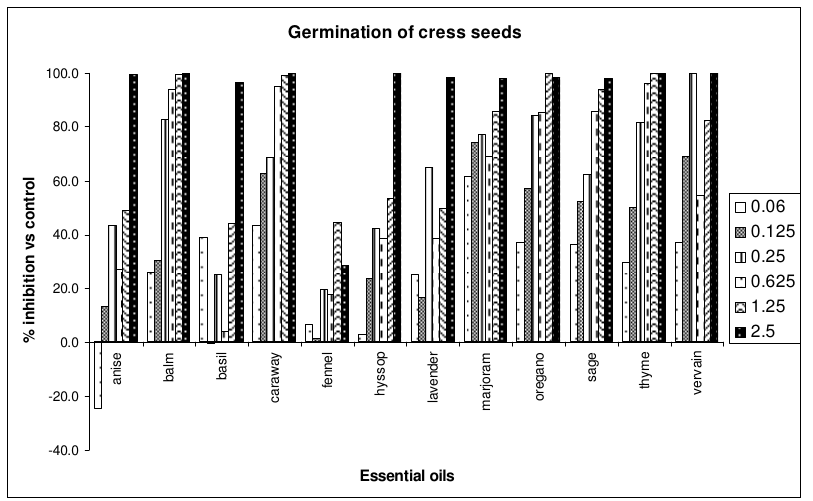
Figure 1. Percent inhibition of germination of Lepidium sativum seeds treated with different doses of essential oils.